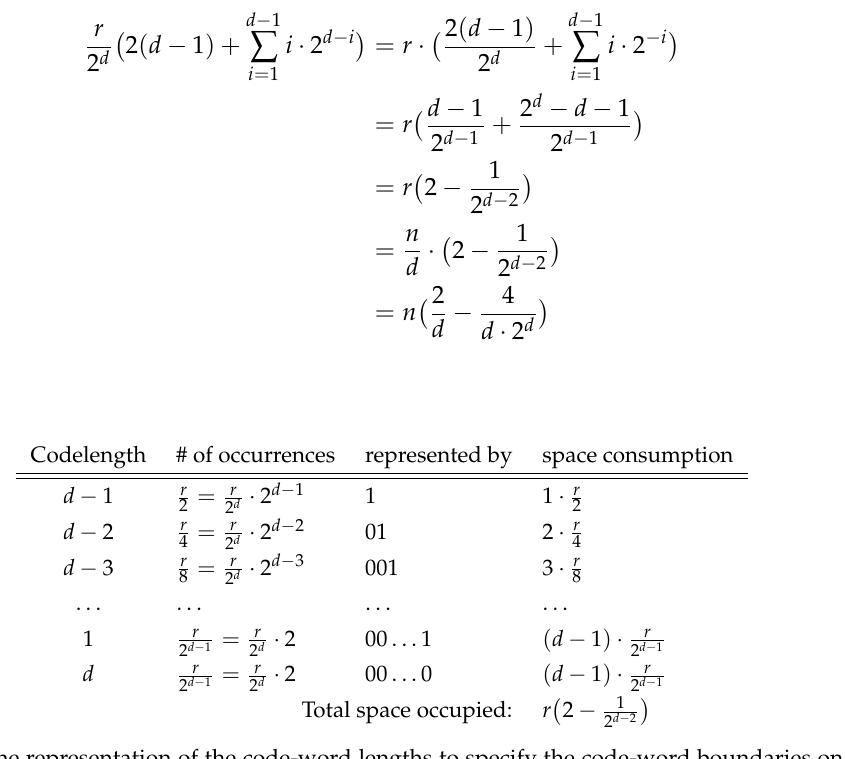
Figure 2. The representation of the code-word lengths to specify the code-word boundaries on the NPF